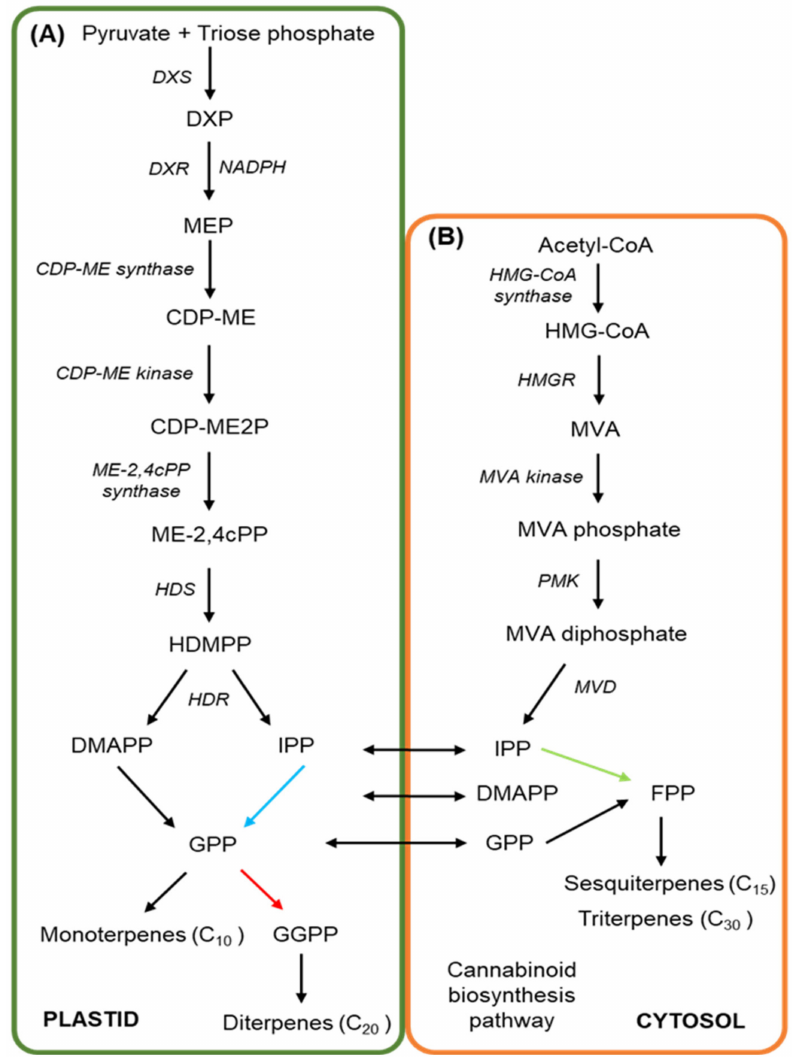
Figure 2. An overview of the mevalonate and methylerythritol 4-phosphate pathways in Cannabis sativa . The MEP ( A ) and MVA ( B ) pathways both produce terpenoid precursors, as well as the substrate for cannabinoid production, GPP. ( A ) The MEP pathway begins in the plastid with the condensation of pyruvate and glyceraldehyde 3-phosphate by DXS to produce DXP, prior to a series of enzymatic reactions to produce HDMPP. HDR then converts HDMPP to IPP and DMAPP, serving as the precursor to GPP, GGPP, and subsequently monoterpene and diterpene production. ( B ) The cytosolic MVA pathway is initiated by the conversion of acetyl-CoA to HMG-CoA and then to MVA, catalysed by the regulated, and rate-limiting enzyme, HMGR. MVA undergoes phosphorylation and then is decarboxylated to produce IPP, which is then converted to FPP as the basis for sesquiterpene and triterpene synthesis, or for GPP production for use in the cannabinoid biosynthesis pathway. The polyketide pathway is initiated when acetyl-CoA is carboxylated to malonyl-CoA, which in turn serves as the precursor for the fatty acid chains used to produce hexanoate (Figure 3) [254,255,261]. The acyl-activating enzyme (AAE), which in Cannabis is encoded by two putative genes, termed CsAAE1 and CsAAE3 , with the encoded proteins localised to the cytoplasm and peroxisome, respectively, where they function to catalyse the synthesis of hexanoyl-CoA from hexanoate [255]. Condensation of hexanoyl-CoA, together with three malonyl-CoA molecules, is subsequently catalysed by the polyketide synthases, tetrake- tide synthase (TKS), or olivetol synthase [284,285]. The product of these two synthases, and post a final round of aldol cyclisation by the olivetolic acid cyclase (OAC)